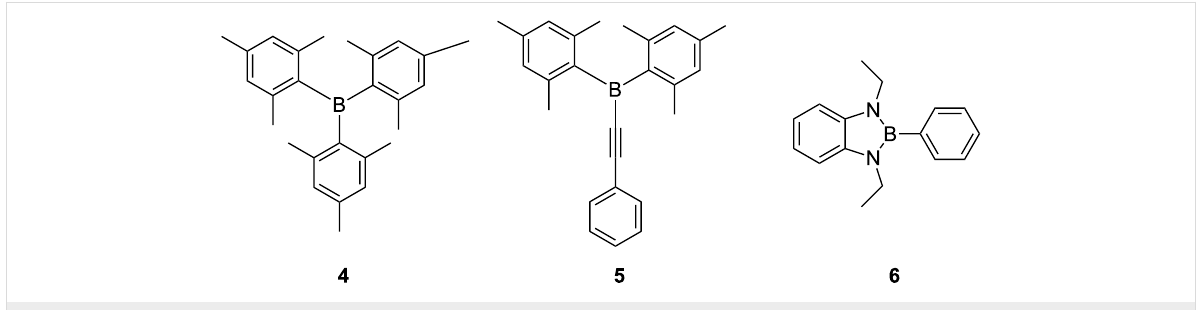
Figure 2: Structure of π -conjugated three-coordinate organoboron compounds 4 and 5 .